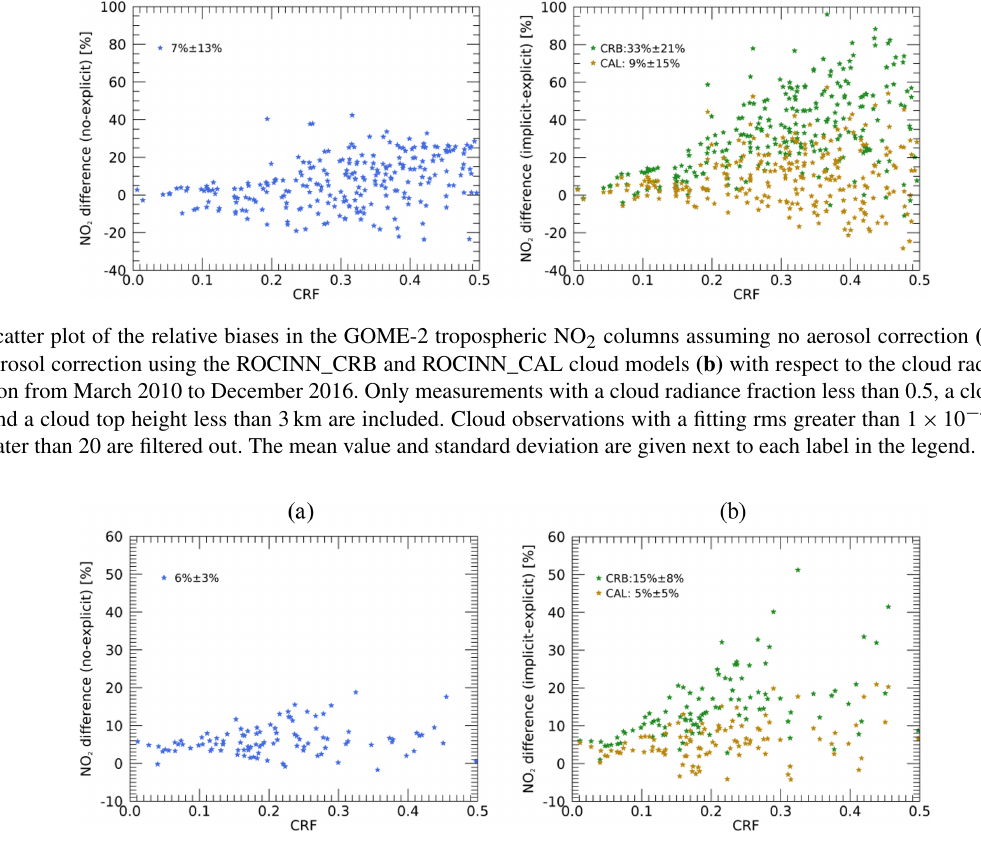
Figure 19. Similar to Fig. 18 but for Bujumbura station from December 2013 to December 2015.